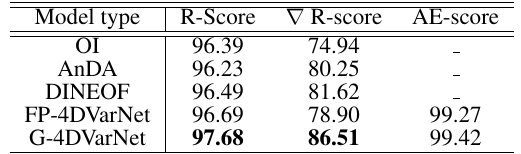
Table 1. Interpolation performance of the benchmarked schemes for SSH interpolation from nadir altimeter and SWOT wide-swath altimeter data : reconstruction performance for SSH fields and their gradient norms for the considered validation period. We refer the reader to the main text for the definition of the different scores and the details on the benchmarked